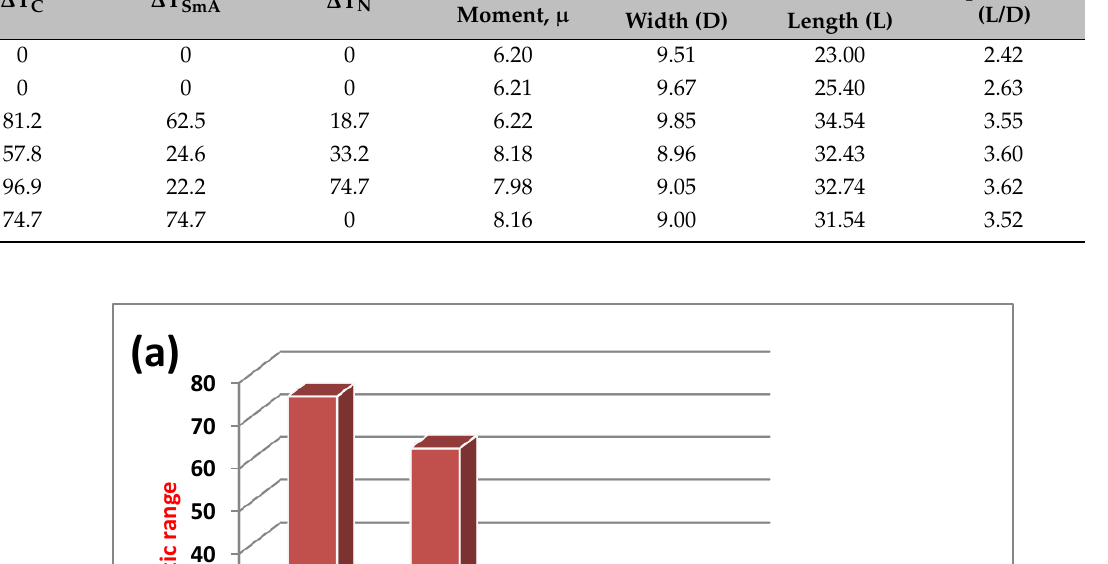
Table 2. Mesomorphic parameters, polarizability, α , and aspect ratio of the investigated compounds.